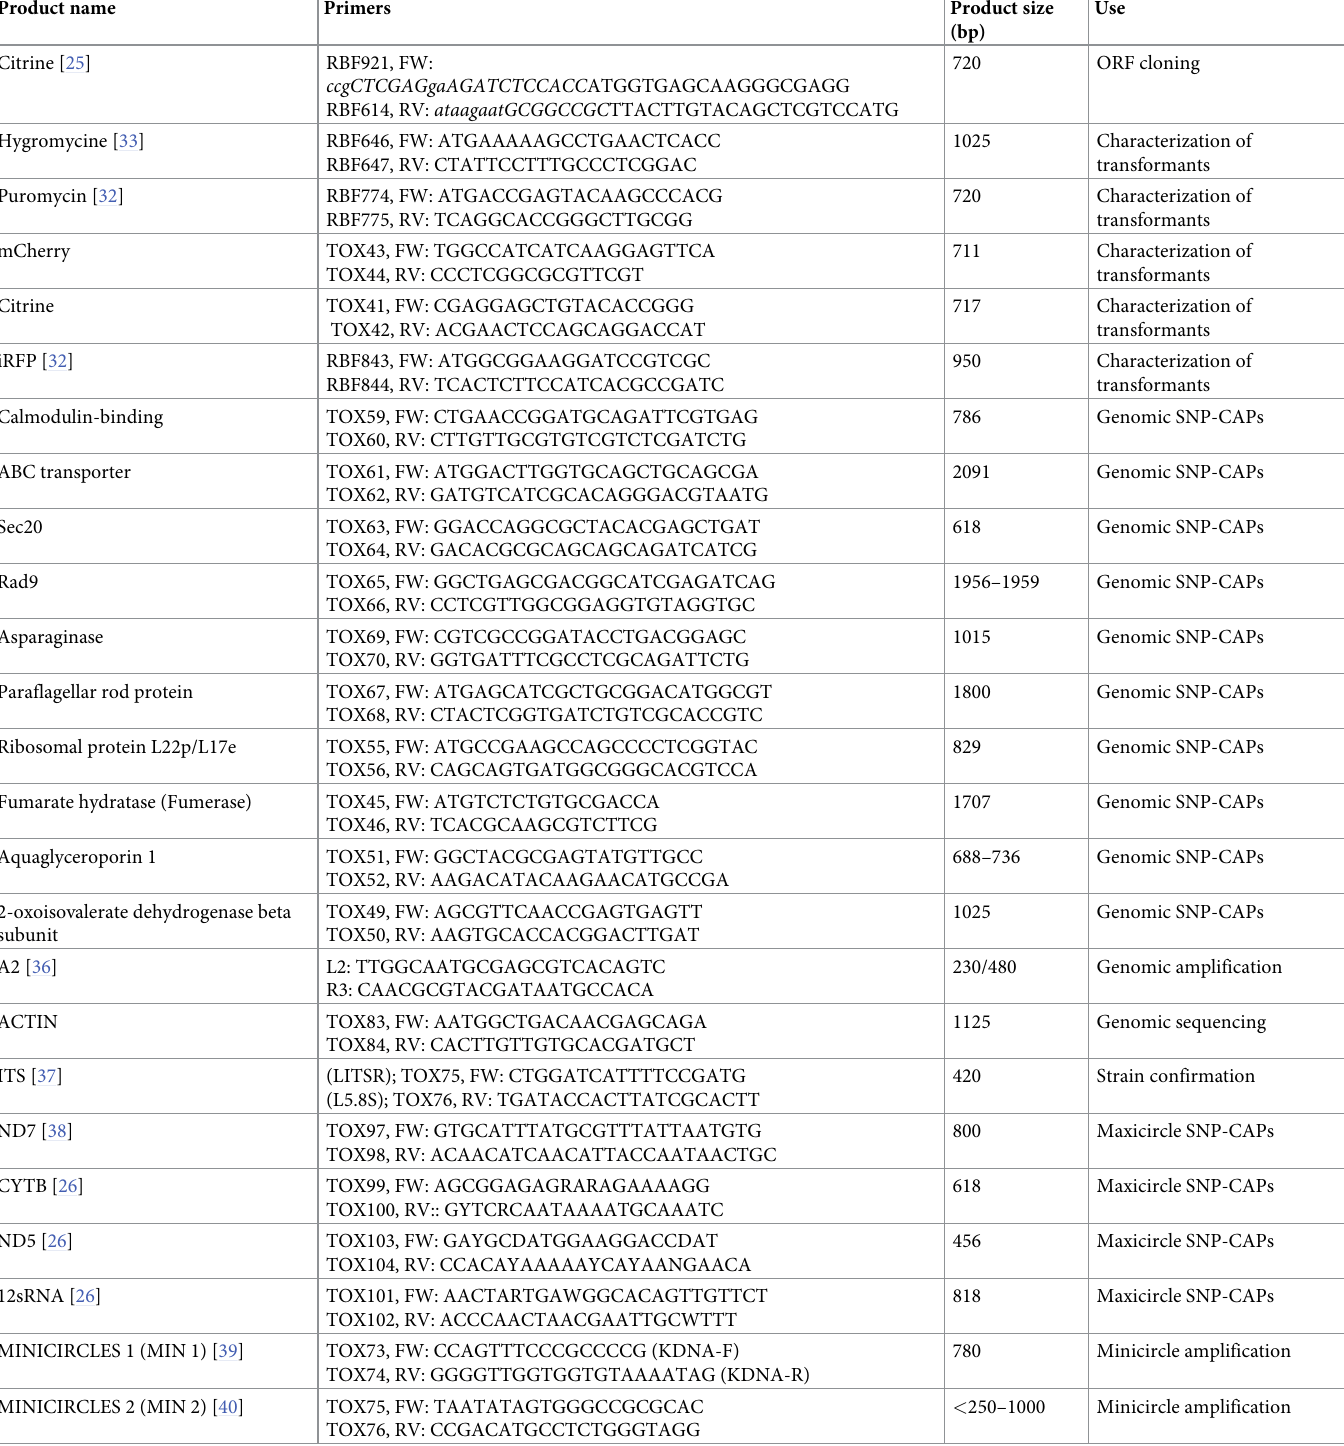
Table 1. Primers used in this